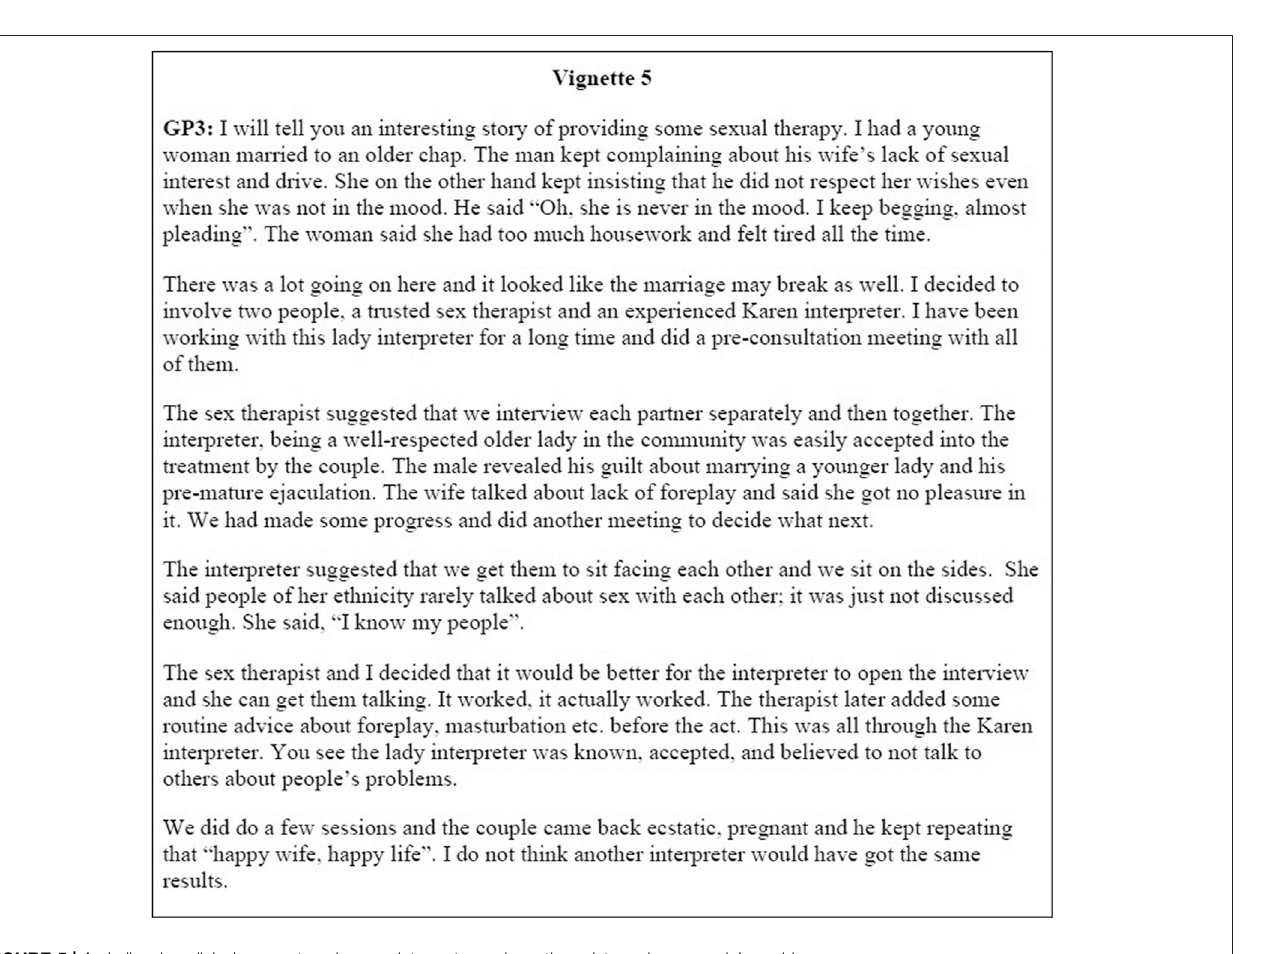
FIGURE 5 | A challenging clinical encounter where an interpreter and sex therapist resolve a couple ’ s problem.